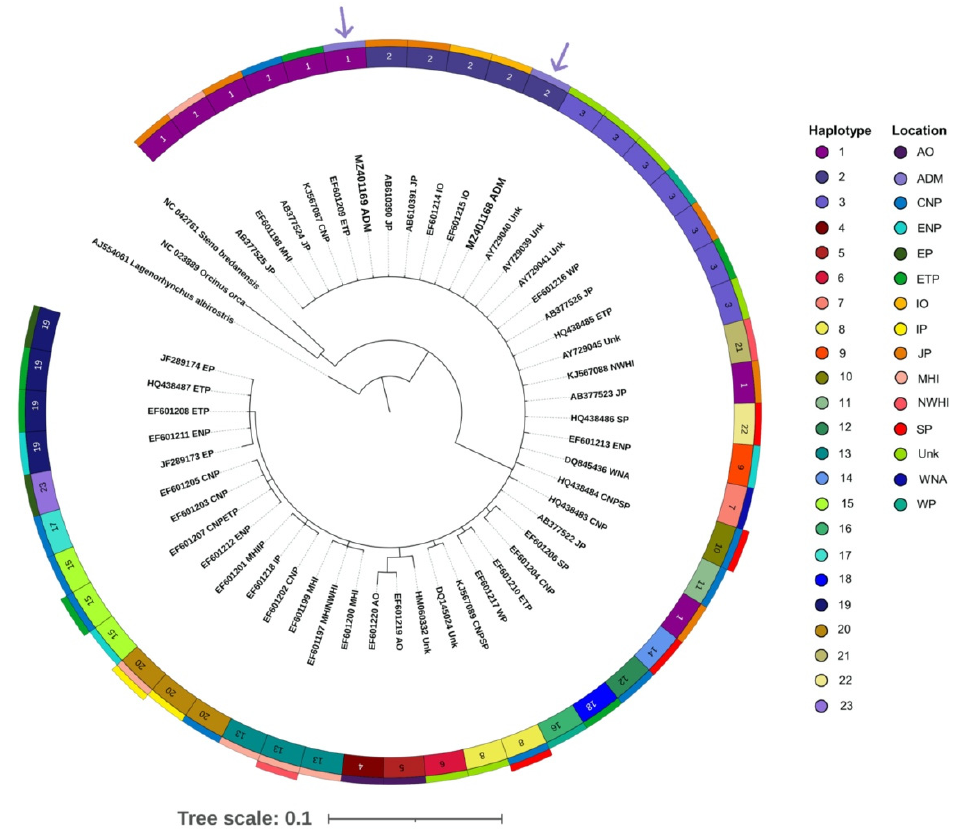
Figure 6. Bayesian phylogenetic tree of false killer whales based on 323 bp alignment of mitochondrial DNA control regions. Accordingly, 48 sequences of false killer whales were obtained from the NCBI database, while two sequences were obtained from this study. The white-beaked dolphin ( Lagenorhynchus albirostris AJ554061), rough-tooth dolphin ( Steno bredanensis NC 042716), and killer whale ( Orcinus orca NC 023889) were utilized as out groups. The circular bands of color around the tree indicate haplotype: first layer and location, second and third layers (inner to outer). Purple arrows indicate samples from Thai Andaman Sea. Abbreviations of location are as follows: ADM,